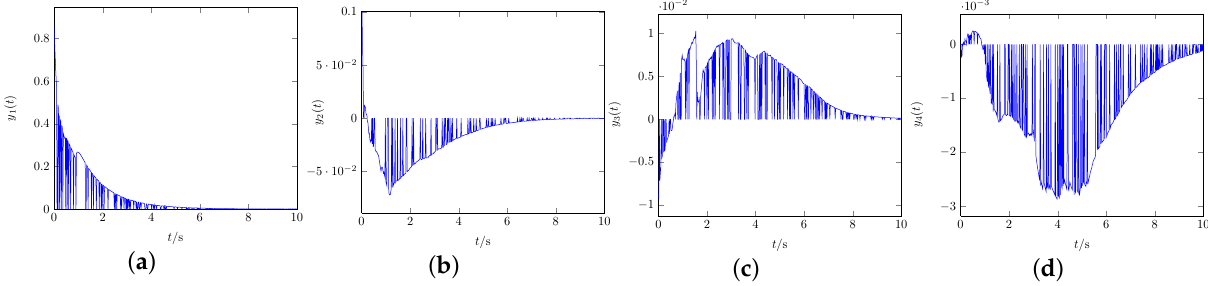
q i ( t ) = 0.2. ( a ) Output −